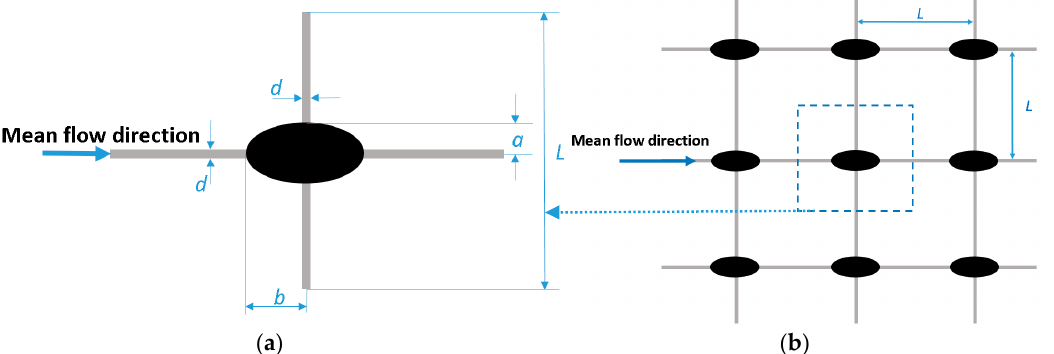
Figure 2. The geometrical characteristics of the pillar-like feed spacer.